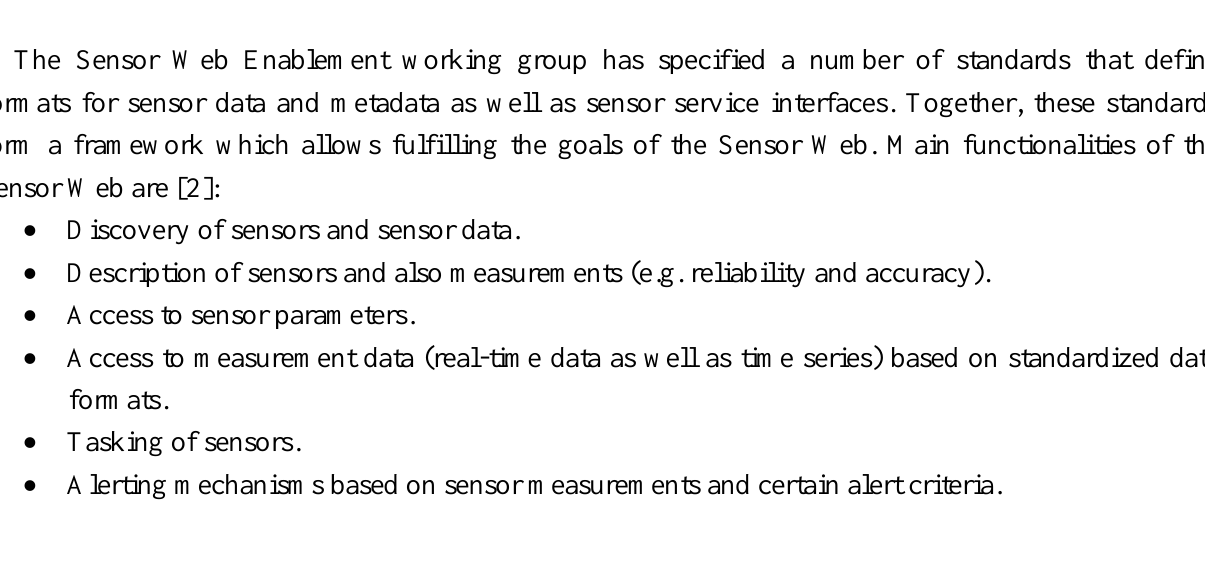
Figure 1. Overview of the Sensor Web Enablement